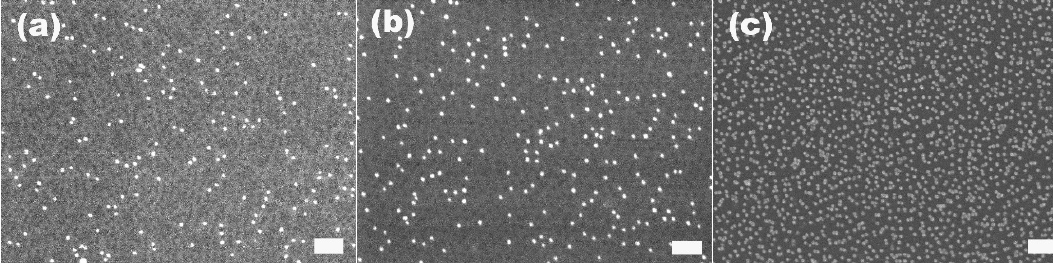
Figure 4. SEM images of S2VP film immersed in 20 nm gold particle suspension at 6 ° C ( a ); 25 ° C ( b ); 60 ° C ( c ) for 1 h. The scale bar is 200